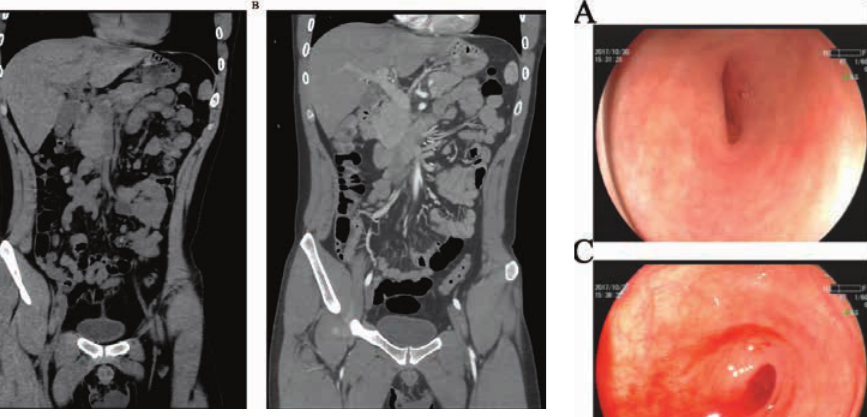
Figure 1: No lesion was found in the Contrast-enhanced CT and the appendix displayed normal.